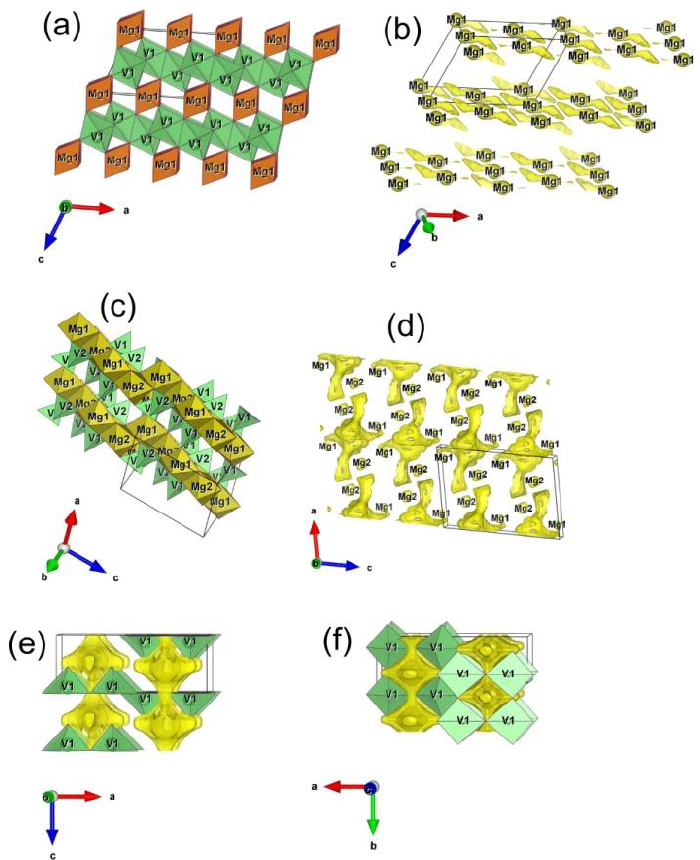
Figure 6. Models of migration pathways for Mg 2+ ion obtained by BVS analysis of the phase constituents of MgVO-LT. Polyhedral representation of Mg 2 VO 6 ( a ) and BVS map within its structure ( b ). Polyhedral representation of α -Mg 2 V 2 O 7 ( c ) and BVS map within its structure ( d ). View on c- ( e ) and d-channels ( f ) within α -V 2 O 5 . BVS volumes are defined by ± 0.1 v.u. mismatch from the valence +2 of